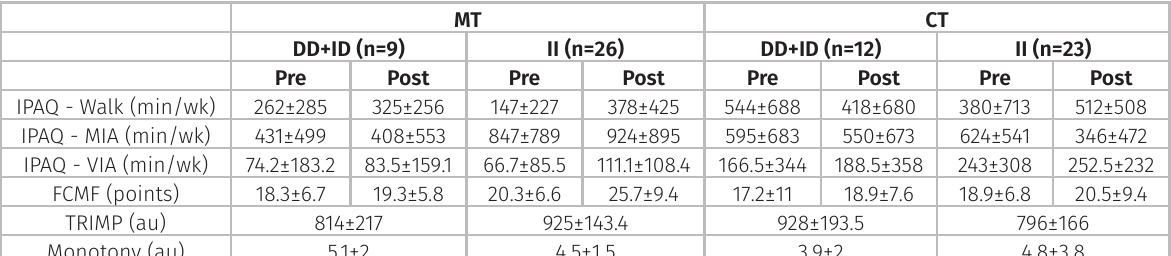
Table III. Physical activity level, nutritional evaluation, and training load of MT and CT groups related to ACE polymorphism.